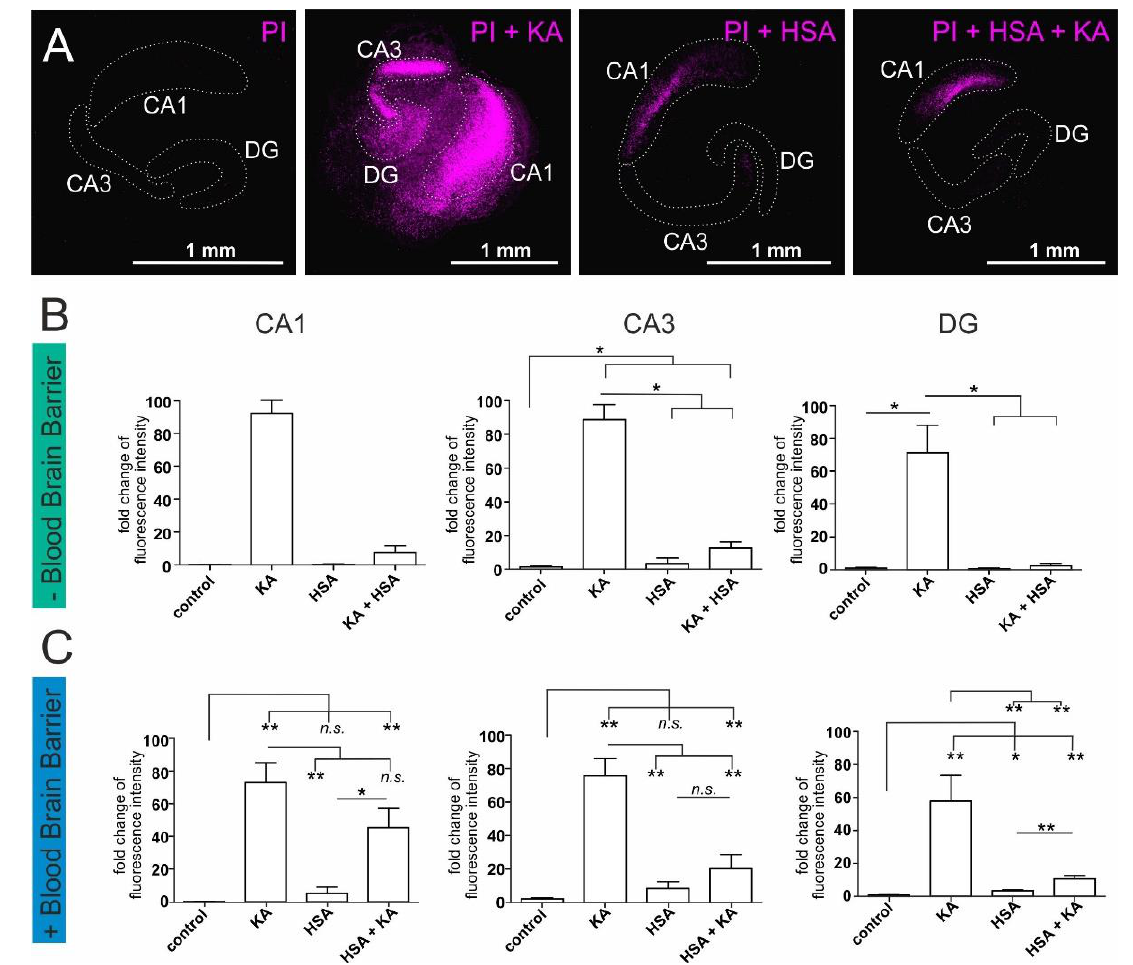
Figure 2. Human serum albumin-mediated protection against excitatory stress applied on organotypic mouse hippocampus slice cultures. Treatment of hippocampal slice cultures with kainic acid (KA) results in cell death which can be measured by staining with propidium iodide (PI) (purple color). ( A ) Exemplary pictures of hippocampi in the respective treatment conditions with PI alone as untreated control, PI+KA, PI+ human serum albumin (HSA), and PI+KA+HSA. For better visibility, the fluorescence intensity of these exemplary pictures was amplified. The hippocampal regions are encircled with a dotted line. More unmodified exemplary pictures of PI-stained hippocampal slices can be found in the supplementary material (Supplemental Figure S1). ( B ) Cell death measurement in the cornu ammonis region 1 (CA1), the cornu ammonis region 3 (CA3), and the Dentate gyrus (DG) of hippocampal slice cultures without blood-brain barrier. ( C ) Cell death measurement in the CA1, the CA3, and the DG of hippocampal slice cultures on top of an artificial blood-brain barrier. Each experiment was performed using 3–4 biological replicates. PI: propidium iodide, KA: kainic acid, HSA: human serum albumin, CA1: cornu ammonis region 1, CA3: cornu ammonis region 3, DG: dentate gyrus. * p ≤ 0.05, ** p ≤ 0.01 was considered significant. n.s . not significant.